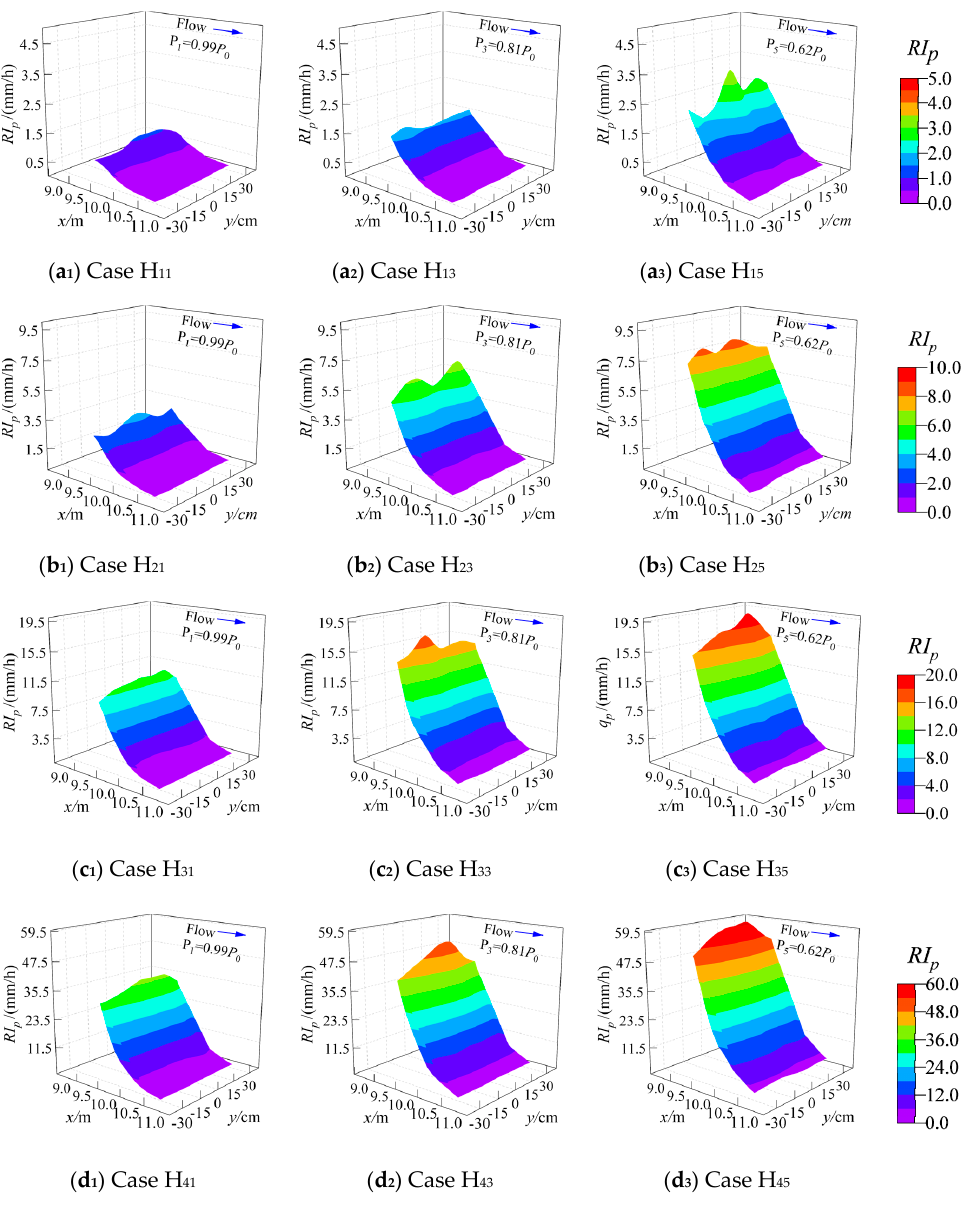
Figure 4. Rain intensity distribution of each point in Region I a ff ected by low ambient pressure. ( a ) Q = 115.00 m 3 / h and V = 10.65 m / s; ( b ) Q = 120 m 3 / h and V = 11.11 m / s; ( c ) Q = 125.00 m 3 / h and V = 11.57 m / s; ( d ) Q = 130.00 m 3 / h and V = 12.04 m / s.